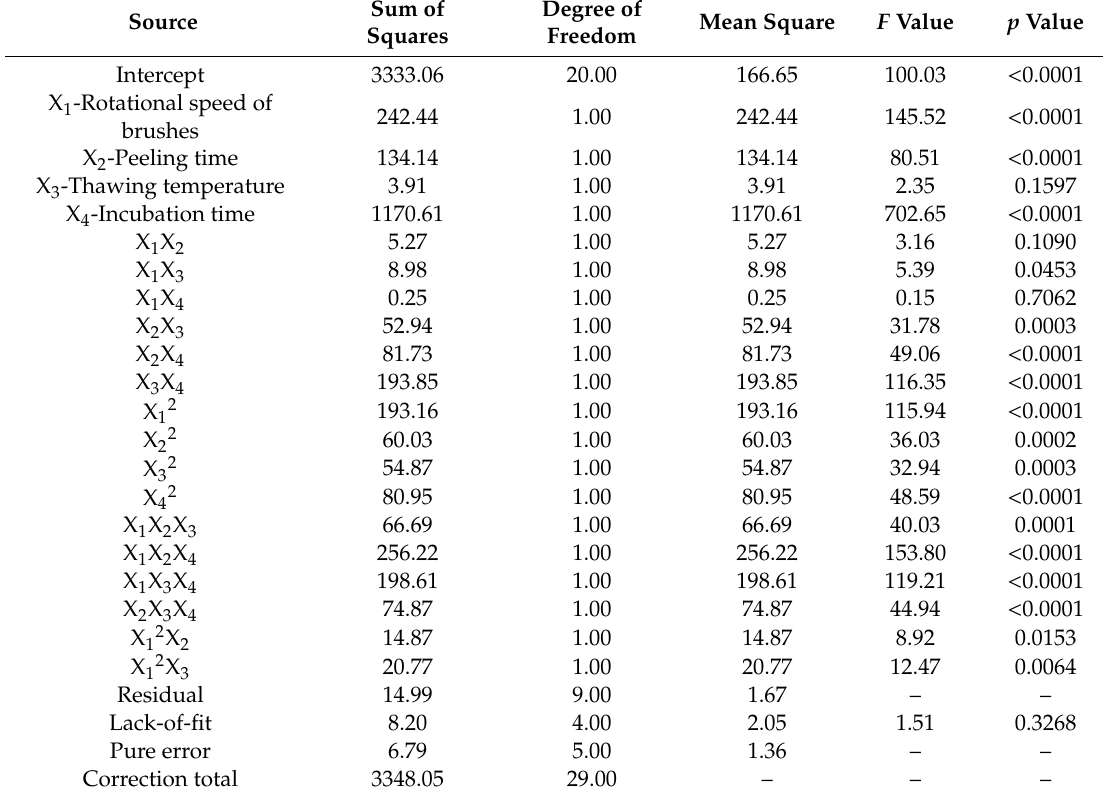
Table 5. ANOVA for reduced cubic equation for the e ff ect of FTP, the rotational speed of the brushes, and the peeling time on the peel loss ( PL ) of cassava tubers. Sum of Degree of Mean Source Squares Freedom